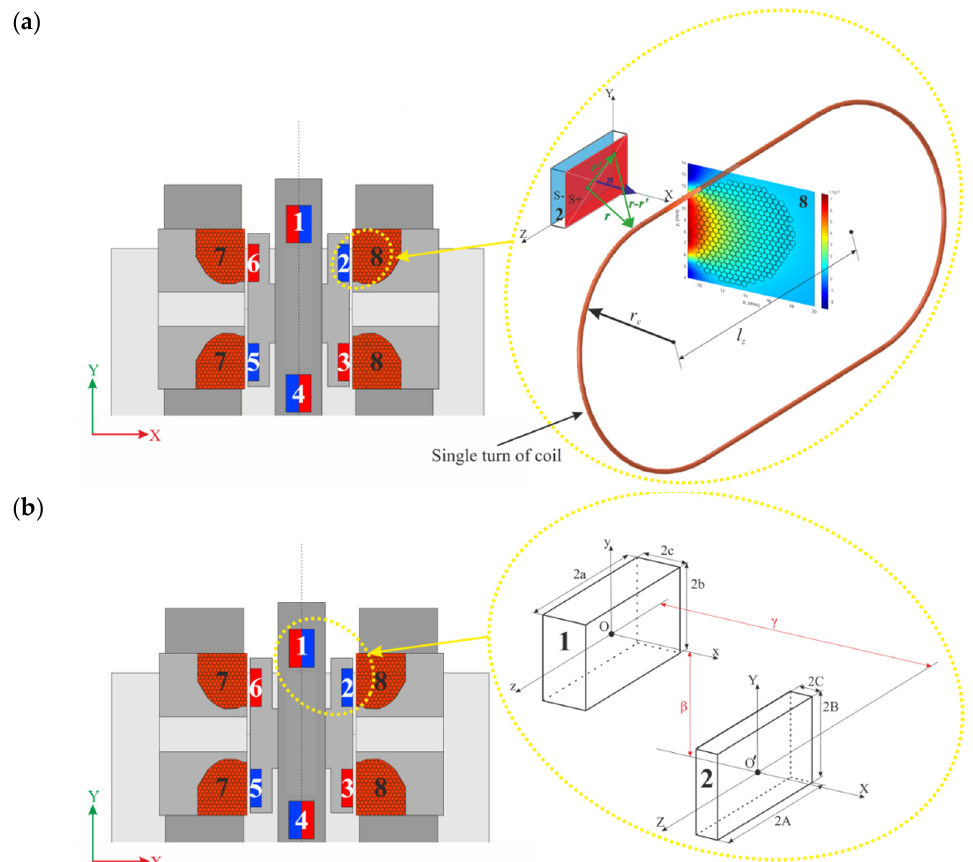
Figure 3. Schematic diagram illustrating the magnetic field computation strategy for calculations of: ( a ) magnetic flux derivative for each coil turn, ( b ) magnetic force between permanent magnets. 1, 4—magnets in vertical support, 2, 3, 5, 6—magnets in yokes, 7, 8—windings, l z —length of rectilinear coil turn segments; r c —radius of curved coil turn segments, 2a, 2b, 2c—the magnet (located in Vertical support) dimensions; 2A, 2B, 2C—magnet dimensions (located in yoke), O , O’ —geometrical centres of magnets, β , γ —distances between